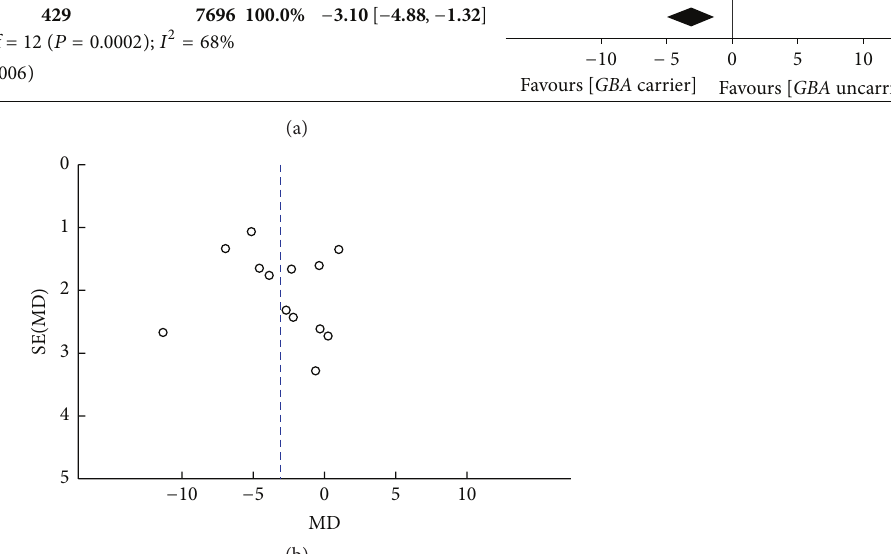
Figure 3: (a) Forest plot of age at onset in GBA + PD and GBA − PD. (b) Funnel plot of age at onset in GBA + PD and GBA −